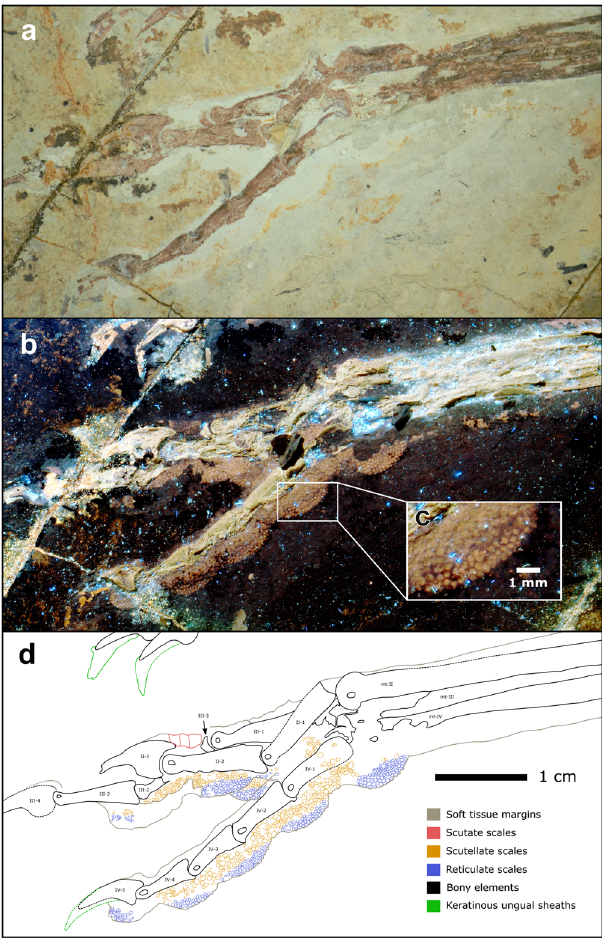
Fig. 3 | Near-complete, articulated right pes of Anchiornis STM 0-147. Fossil under a whitelightand b laser-stimulated fl uorescence. c Close-upofreticulateand scutellate scales on digit IV. d Interpretive drawing, where solid lines indicate preserved structural boundaries, and dashed lines represent assumed or com- pleted boundaries.